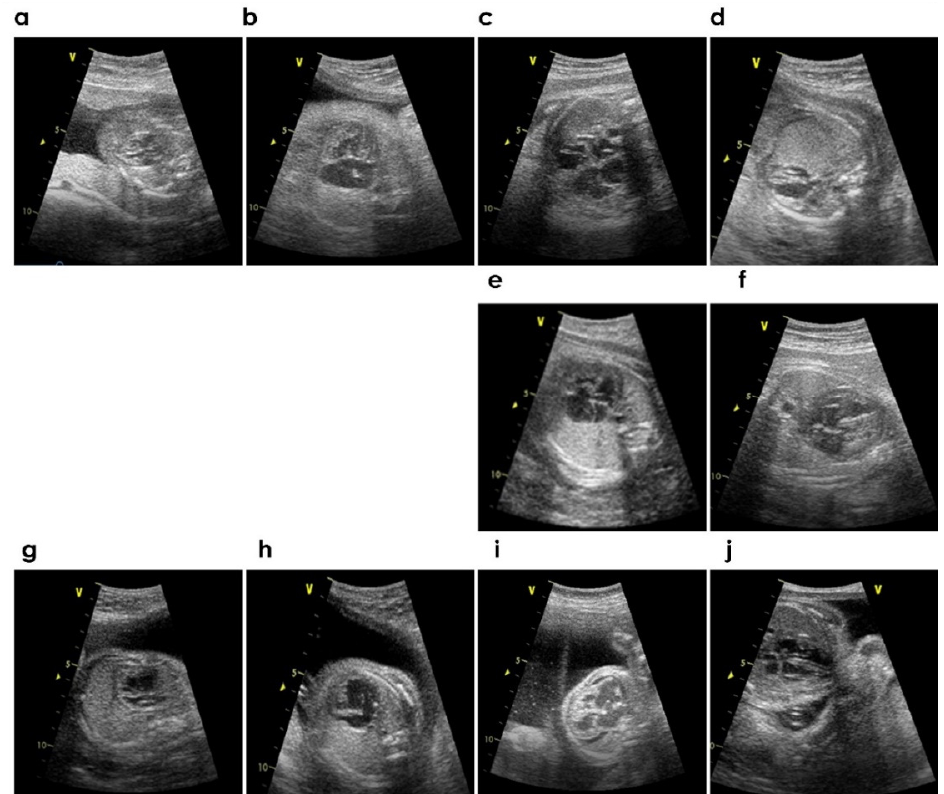
Figure 4. ( a – j ) Sample images with various